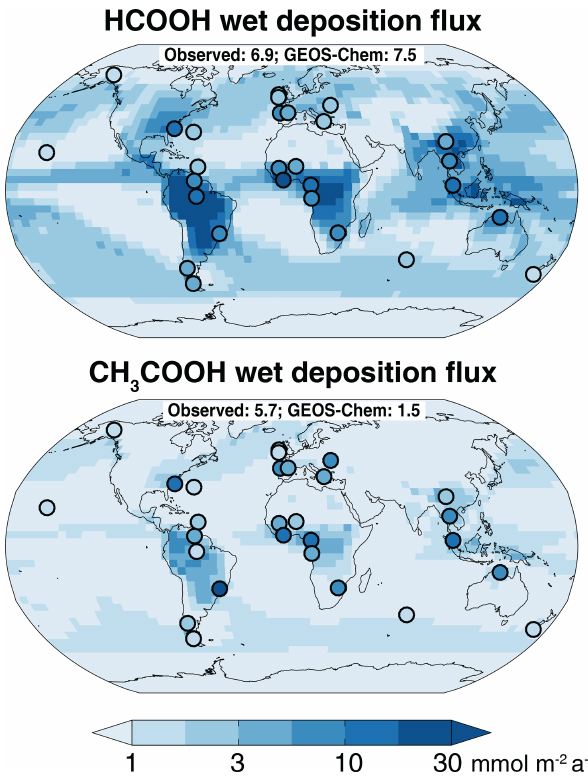
Figure 1. Annual mean wet deposition fluxes of HCOOH and CH 3 COOH. The GEOS-Chem model values (contours) are for the year 2013, and the observations (circles) are for various years as compiled by Vet et al. (2014) and Keene et al. (2015). The com- pilations only include studies that used adequate methods to pre- serve HCOOH and CH 3 COOH in precipitation samples. We ex- clude studies with measurement periods of less than 1 year. For studies that reported only precipitation concentrations, we estimate the deposition fluxes using climatological rainfall data for the cor- responding locations from the Global Precipitation Climatology Center (Meyer-Christoffer et al., 2018). The global mean observed fluxes and the corresponding GEOS-Chem fluxes are shown inset. Table 1. Henry’s law coefficients for the calculations of cloud water and precipitation pH ∗